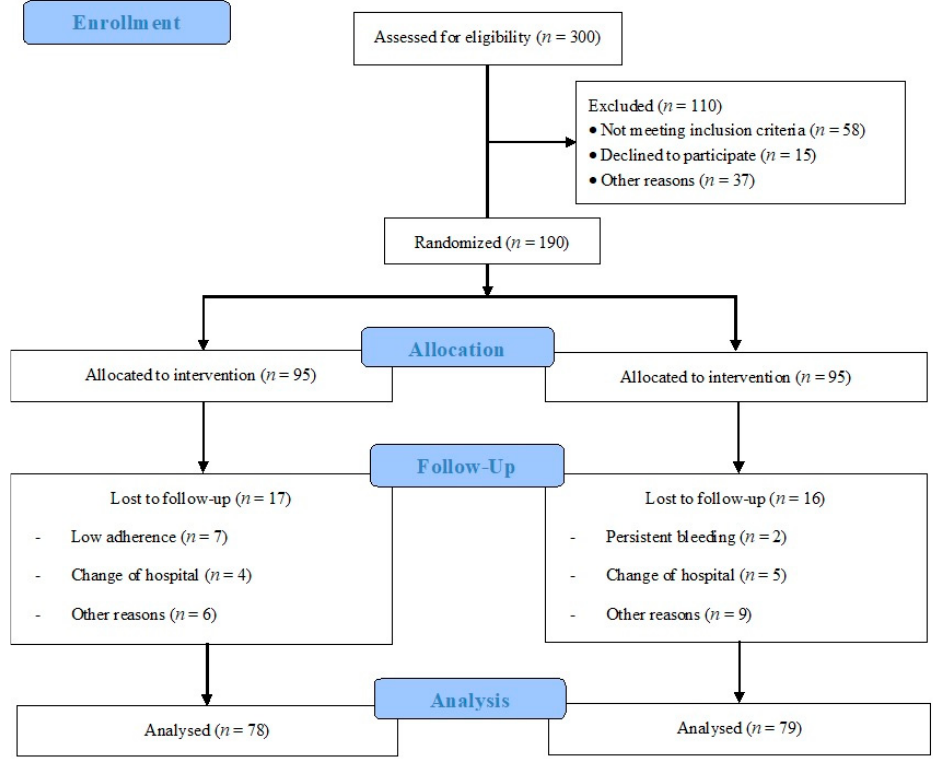
Figure 1. Study population